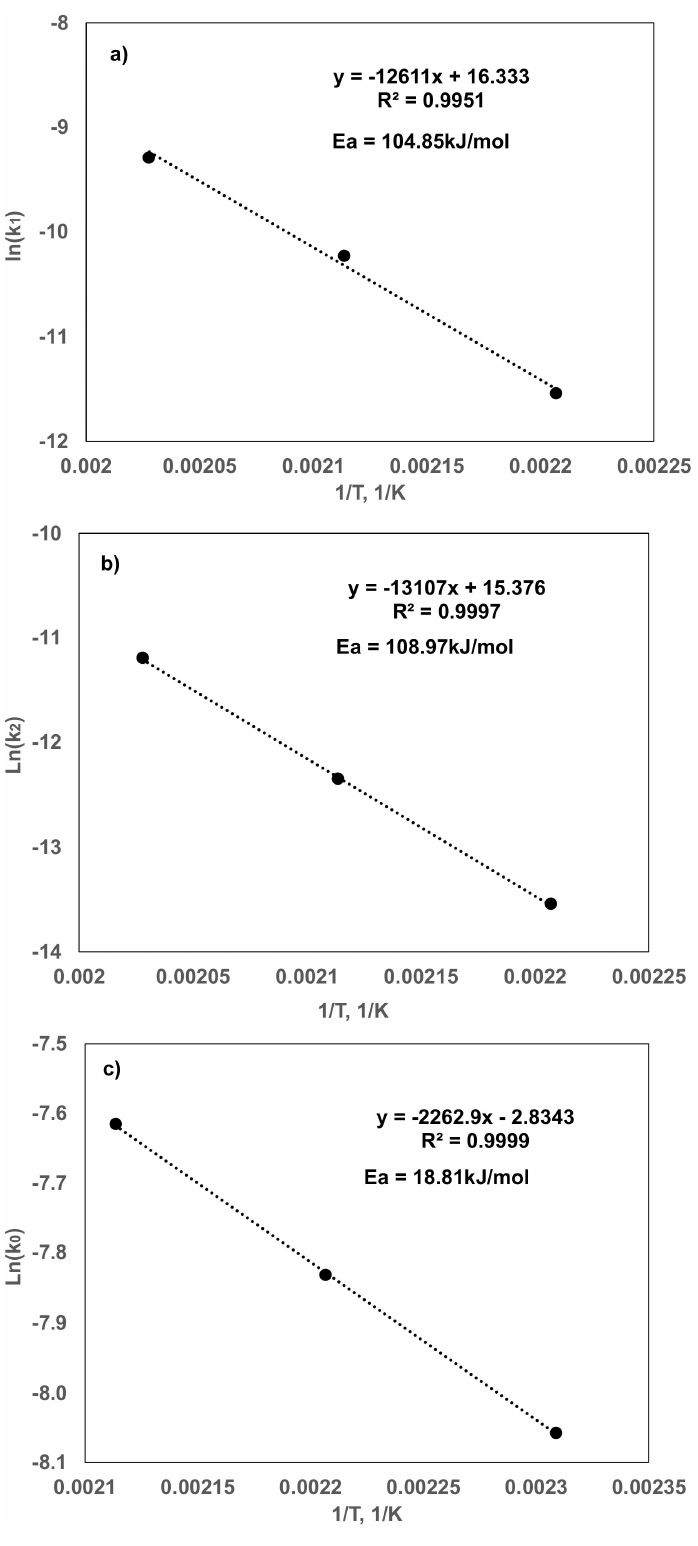
Figure A9. Arrhenius plot: ( a ) Glycerol dehydration, ( b ) Glycerol C-C cleavage, ( c ) Acetol hydro-